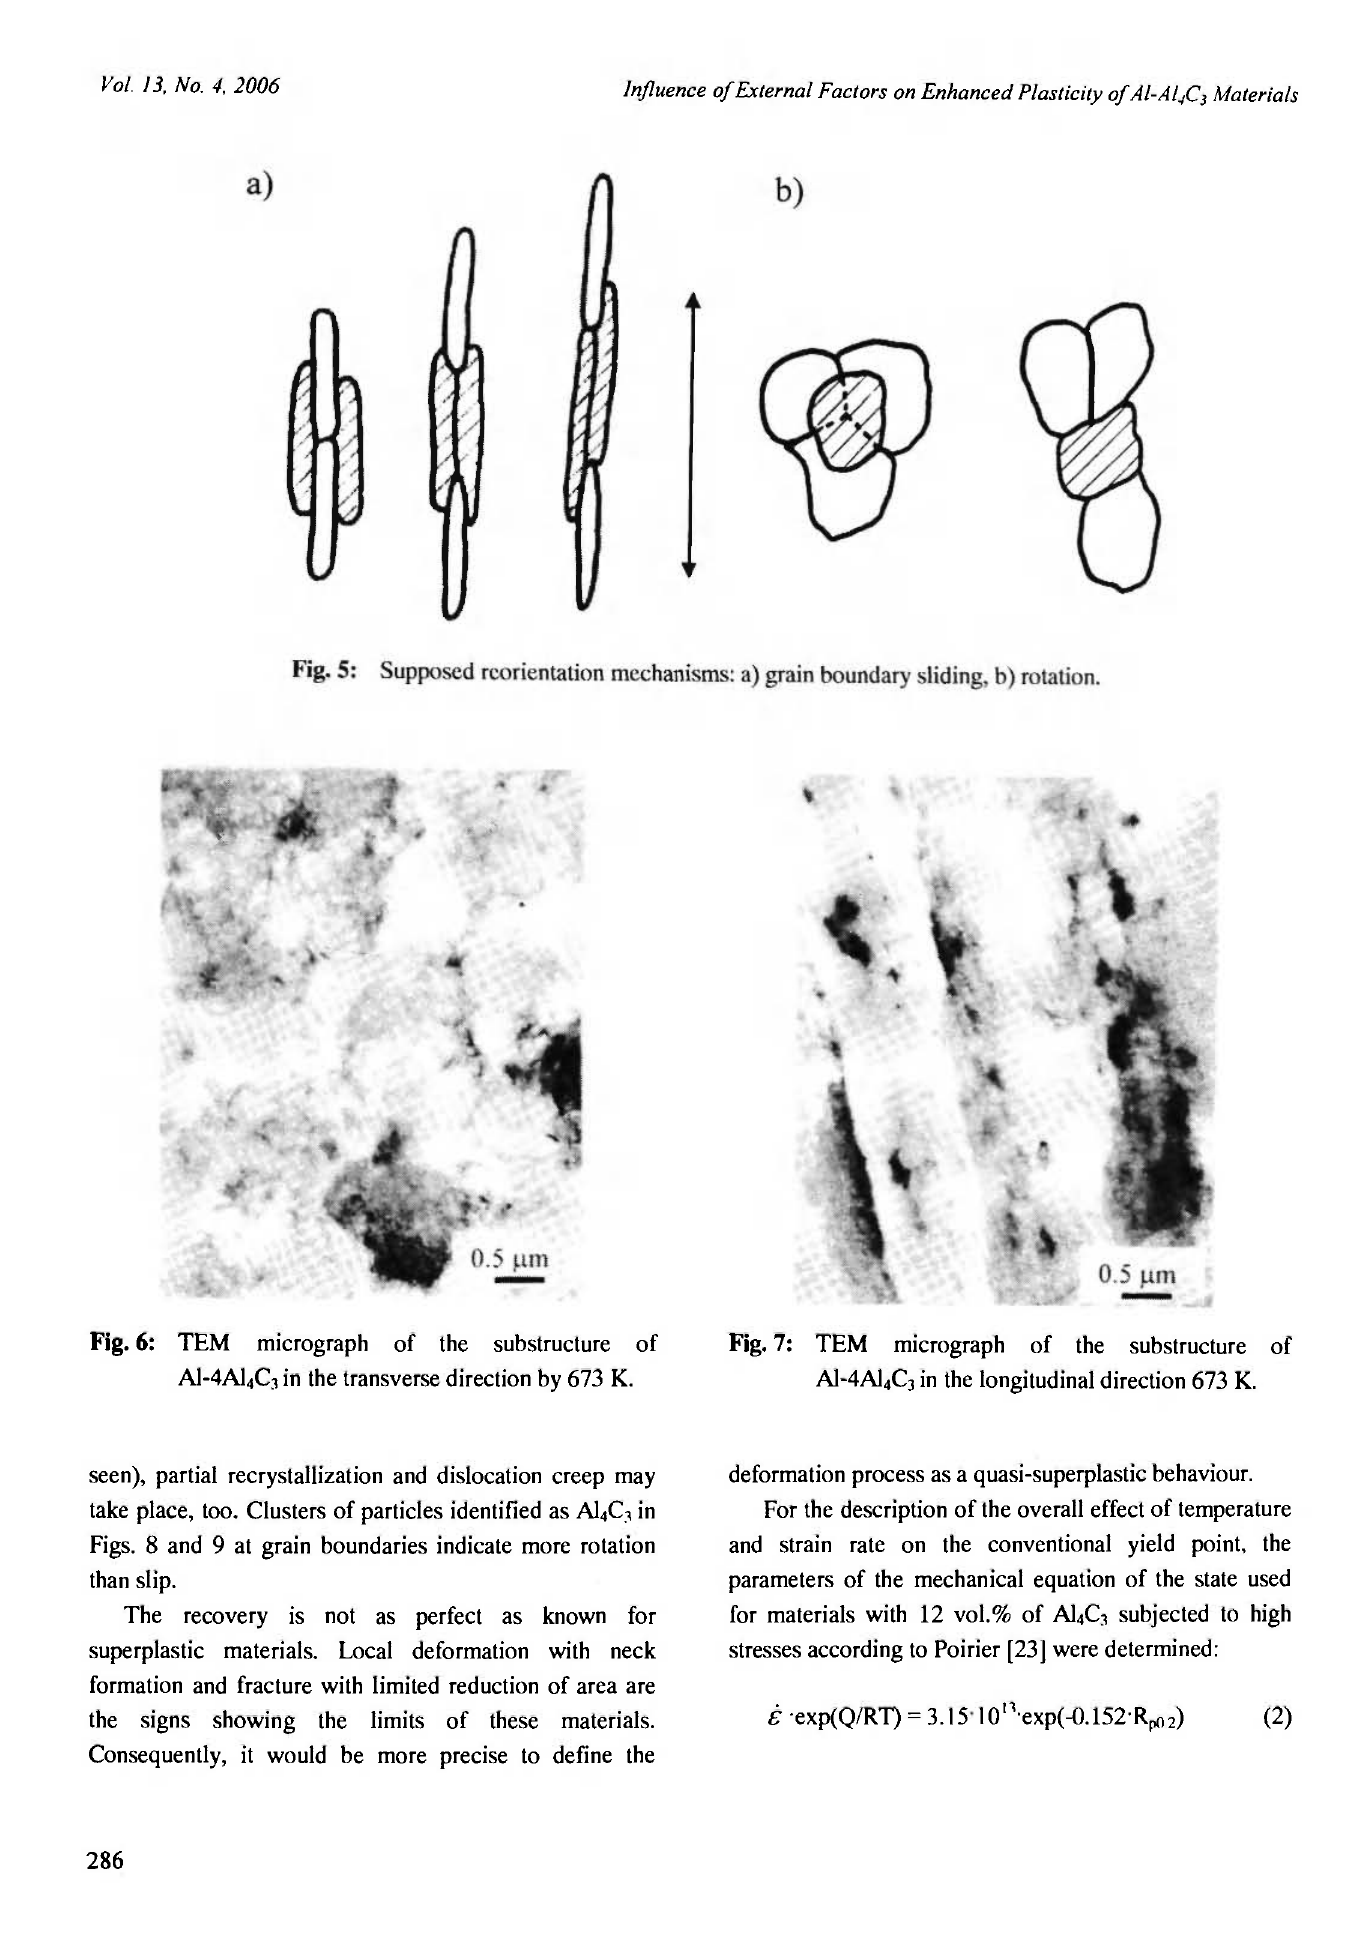
Fig. 6: TEM micrograph of the substructure of AI-4AI4C3 in the transverse direction by 673 K.